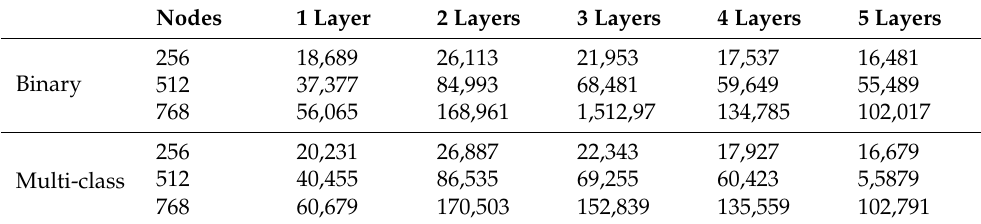
Table 8. The number of parameters of the DNN model.